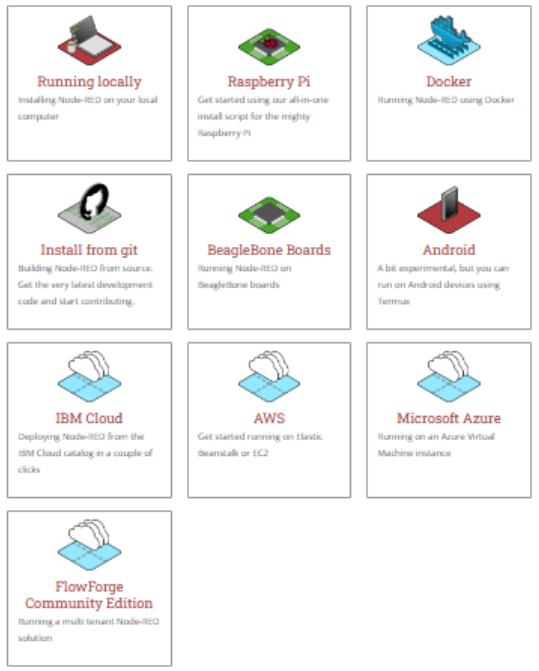
Figure 2. Node-RED environment, source [42].